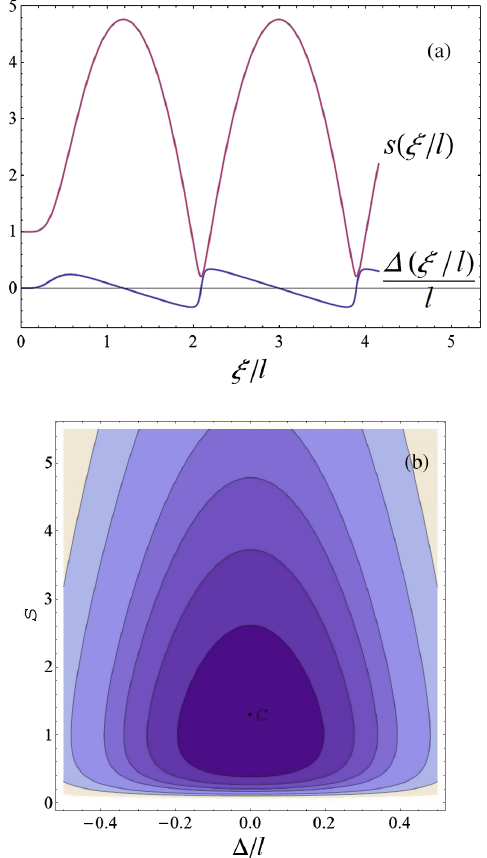
FIG. 3. (a) Solution of (26) for Ml 2 ¼ 26 and the v ð ξ Þ as in Sect. IV of average intensity I ¼ 10 19 W = cm 2 . (b) Paths P ð ξ ; Z Þ around the center C for Ml 2 ¼ 26 , v